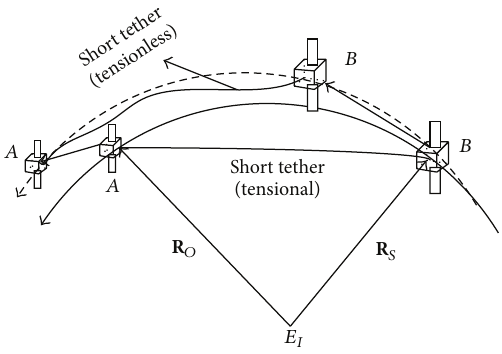
Figure1:Theschematicdiagramofthespacetugsystemwithashort tether similar to the ROGER system during deorbiting.